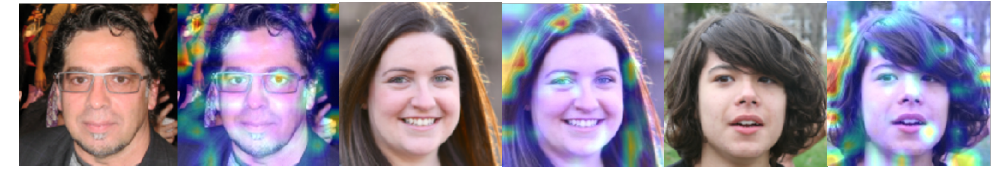
Figure 12. Face images detected as real. In this figure, the real face is from the open-source FFHQ